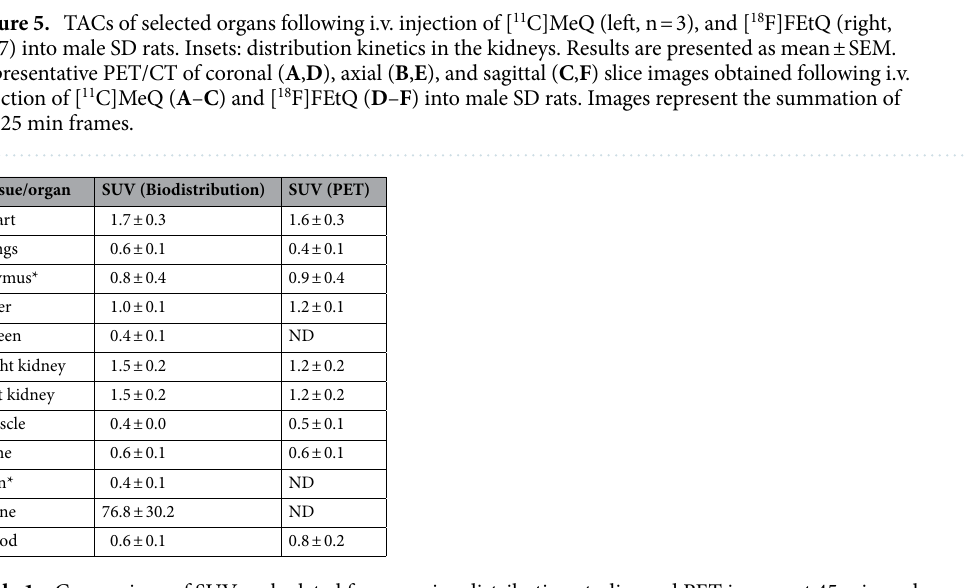
Table 1. Comparison of SUVs calculated from ex vivo distribution studies and PET images at 45 min and from a 35–45 min time interval after injection of [ 18 F]FEtQ, respectively. Results are presented as mean ± S.D (n = 7; in organs marked with an asterisk n = 3). ND, not determined.